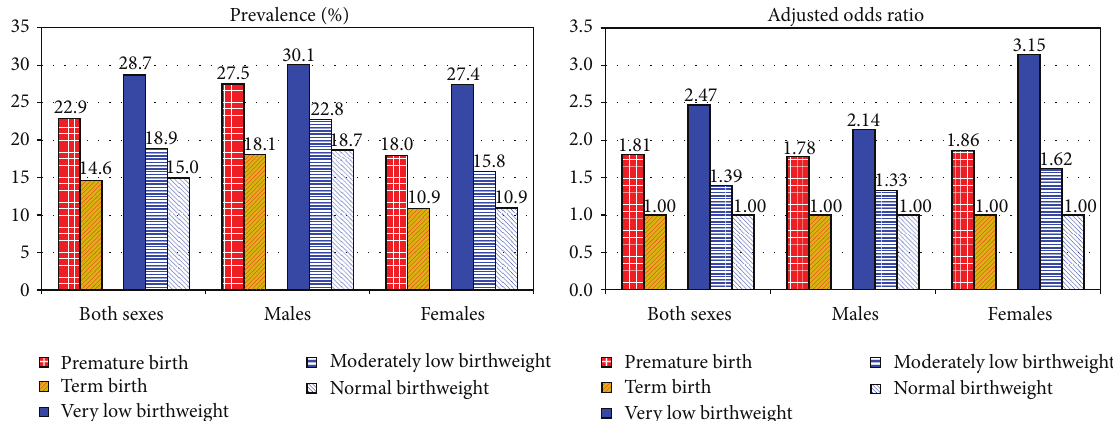
Figure 1: Prevalence (%) and adjusted odds of mental disorders (one or more of the eight conditions) among US children aged 3–17 years by prematurity and low birthweight. Notes . Differences in prevalence and odds between preterm and birthweight categories were all statistically significant at 𝑃 < 0.001 . Odds ratios were adjusted for child’s age, sex, race/ethnicity, household composition, race/ethnicity, household composition, place of residence, household poverty, and education levels. Term birth and normal birthweight were the respective reference categories for the prematurity and birthweight variables. Source . The 2011-2012 National Survey of Children’s Health ( 𝑁 = 80,649).